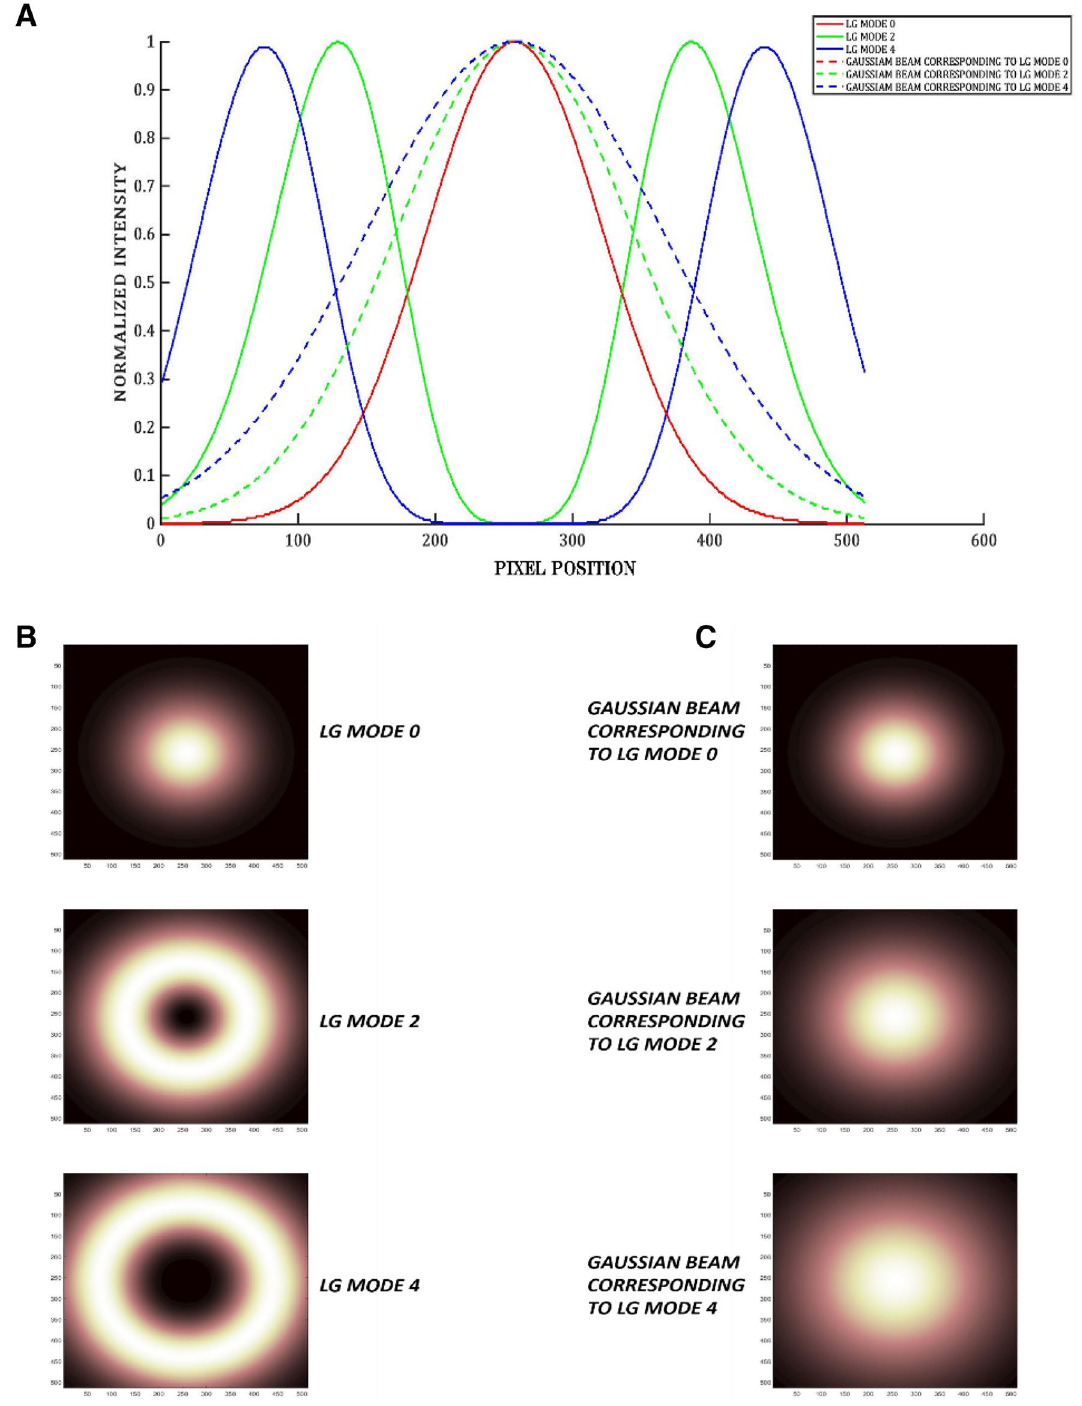
Figure 2. ( A ) Shows the intensity of each simulated LG mode (solid lines) and their corresponding Gaussian beam modes (dotted lines) with respect to the pixel values. ( B ) and ( C ) Show the intensity profile of the LG modes and the corresponding Gaussian beam modes used in the